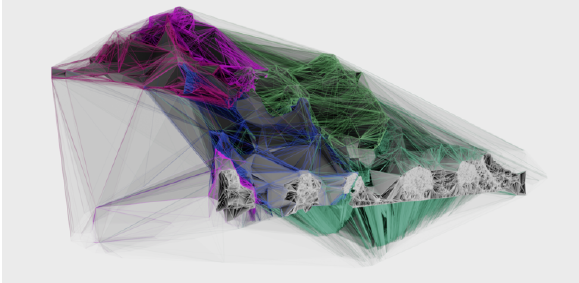
Figure 5. 3M LiDAR points triangulation on a 3x3x3